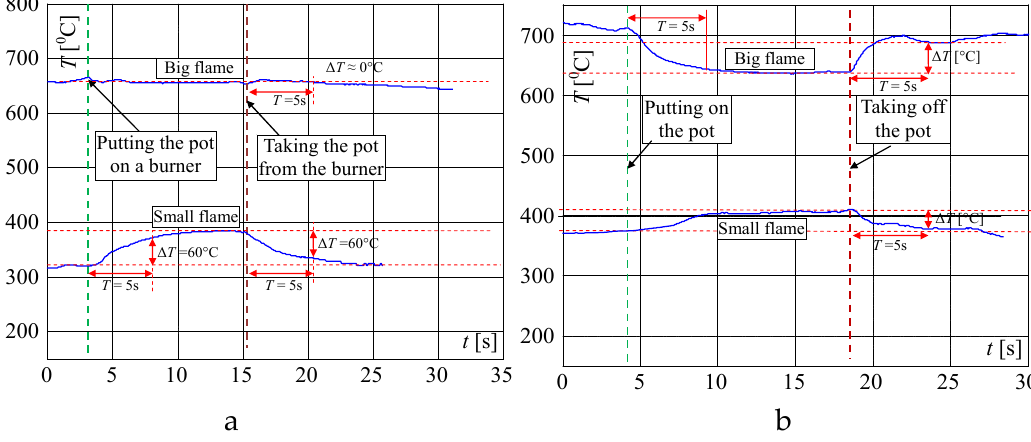
Figure 13. Temperature changes for putting the pot and removing it from a burner when the flame is big and small measured by linear thermocouple located in: ( a ) position 1, ( b ) position 2.